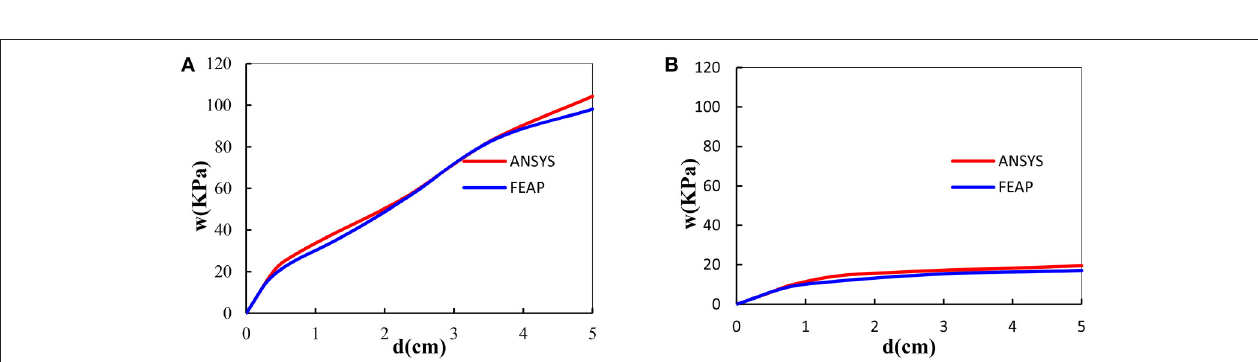
FIGURE 10 | Load vs. displacement curve at the midspan of circular slab: (A) clamped and (B) simple supported.